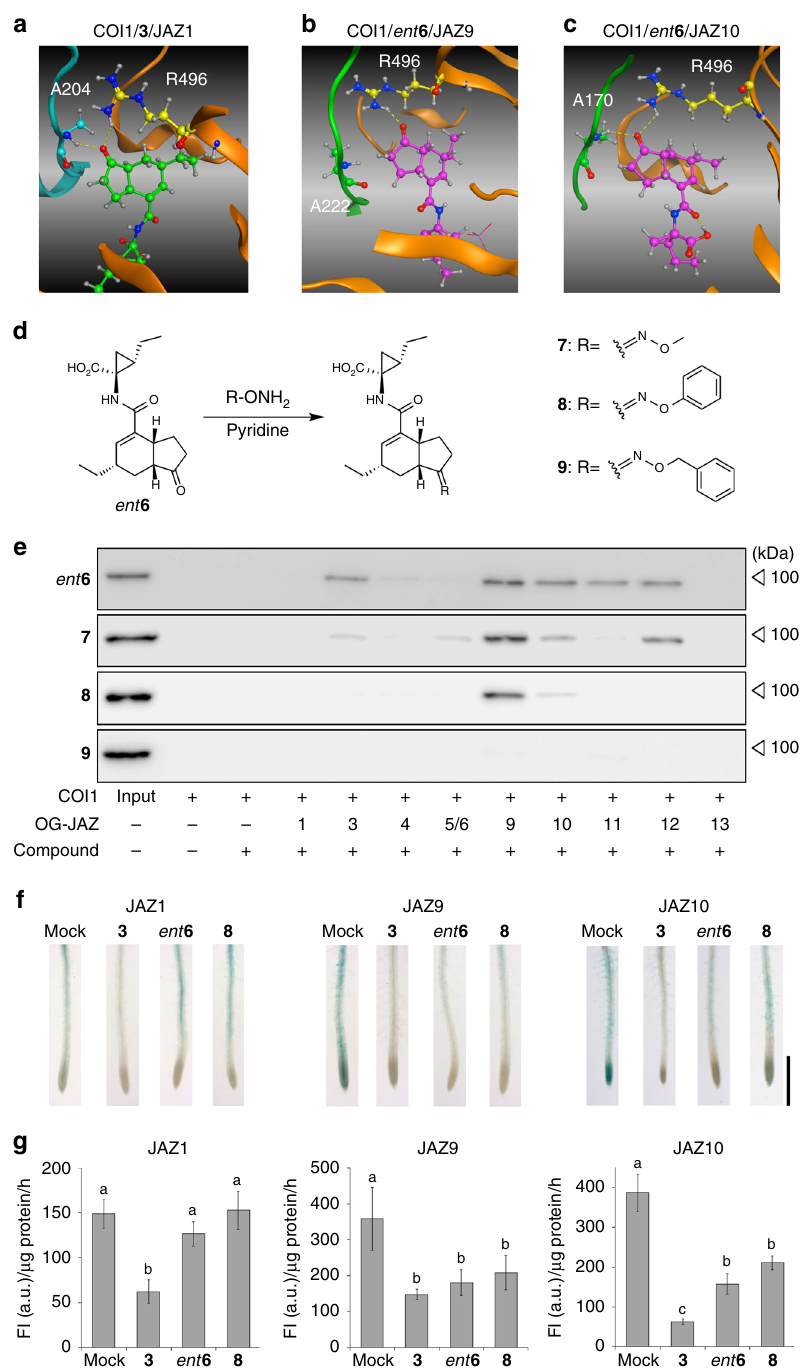
Fig. 3 Rational design of JAZ subtype-selective agonist by an in silico docking study. a The obtained average structure of MD simulation of COI1- 3 -JAZ1. The hydrogen bond between the ketone group of 3 with A204 JAZ1 or R496 COI1 is indicated by a yellow dotted line. b The obtained average structure of COI1/JAZ9 complexed with ent 6 , which was constructed by in silico docking analyses and MD simulation. The hydrogen bond between the ketone group of ent 6 with R496 COI1 is shown as yellow dotted line. c The obtained average structure of COI1/JAZ10 complexed with ent 6 , which was constructed by in silico docking analyses and MD simulation. The hydrogen bond between the ketone group of ent 6 with A170 JAZ10 (corresponding to A204 JAZ1 ) or R496 COI1 is indicated by a yellow dotted line. d Synthesis scheme for compounds 7 – 9 from ent 6 as a starting material and corresponding oxime molecules. e Pull-down assay of puri fi ed GST-COI1 (5 nM) with all OG-conjugated JAZ peptides (10 nM) in the presence of ent 6 , 7 , 8 , or 9 (500 nM). HRP-conjugated anti-GST antibody was used to detect GST-COI1. f Evaluation of GUS activity in the roots of 4-day-old 35S:JAZ1-GUS, 35S:JAZ9-GUS, and 35S:JAZ10-GUS plants. Seedlings were pretreated for 30 min with or without ligand ( 3 , ent 6 , or 8 , 1 µ M), and stained with 5-bromo-4-chloro-3-indolyl glucuronide; the experiments were repeated three times with similar results. Scale bar, 1 mm. g Quanti fi cation of GUS activity in 20 roots of 4-d-old 35S:JAZ1-GUS, 35S: JAZ9-GUS, and 35S:JAZ10-GUS plants ( n = 4). Signi fi cant differences were evaluated by one-way ANOVA/Tukey HSD post hoc test ( p < 0.01). Seedlings were pretreated as described above. Three independent replicates were measured, and values represent mean ± s.d. (Supplementary